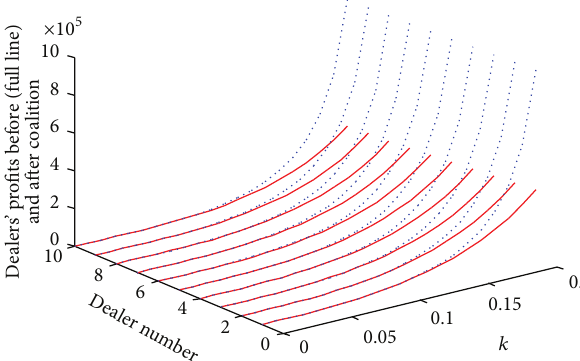
Figure 2: Dealers’ profits with and without coalition ( 𝑇 = 1 ).